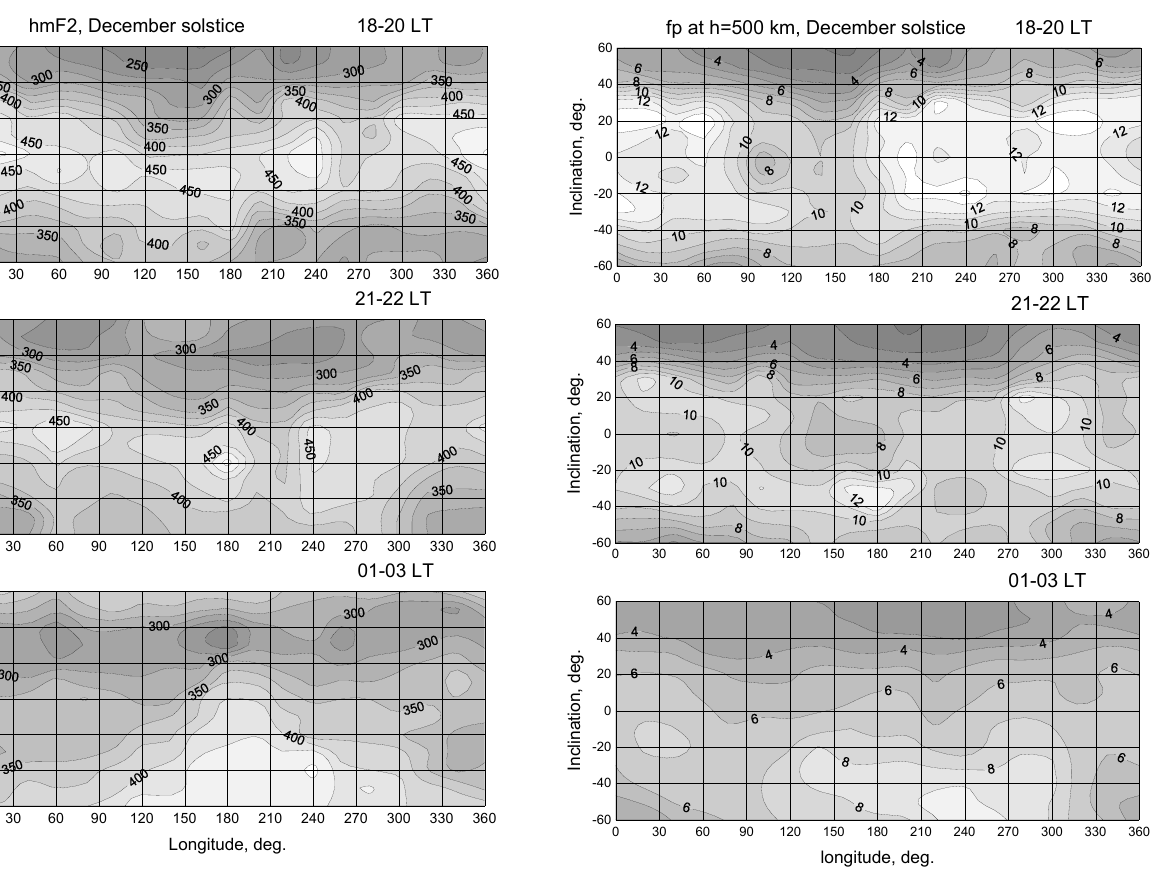
Fig. 4. The same as in Fig. 2 but for fp at a height of